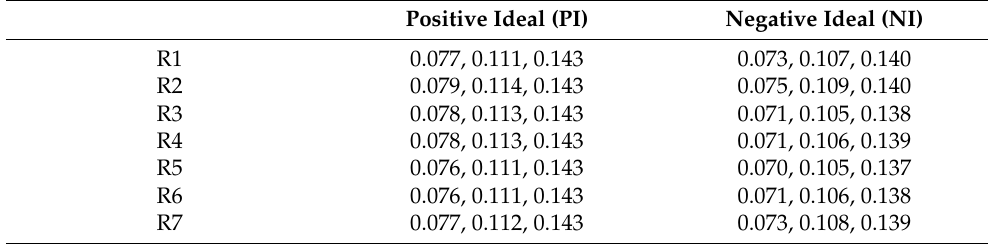
Table 7. The positive as well as negative ideal resolutions.